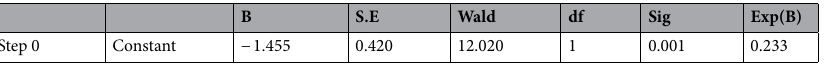
Table 8. Logistic regression analysis for significant predictors of the presence of integron Variables in the Equation. B Regression coefficients, S.E. standard error around the coefficient for the constant, Wald Wald chi- square test statistic, Sig. P value for Wald